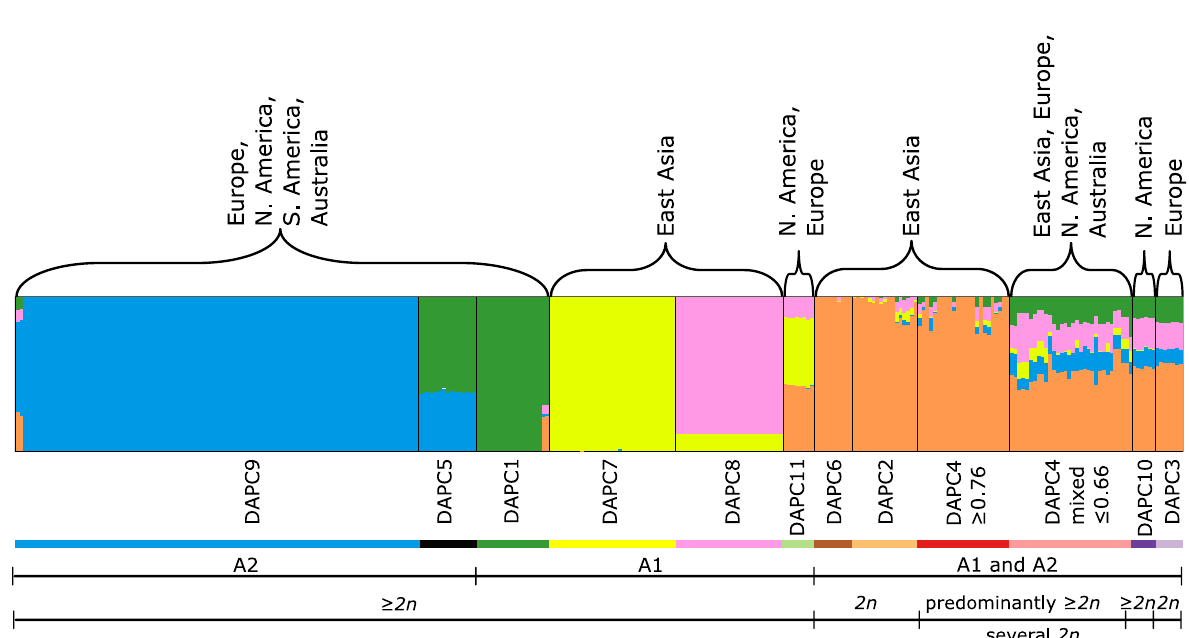
Fig. 1 Bayesian clustering of P. cambivora -related isolates using STRU CTU RE at K 5. Each isolate is represented by a vertical line partitioned × = into coloured sections that represent the isolate’s estimated membership fractions in each cluster. Black lines separate isolates from different DAPC groups (see main text for details). The horizontal colour bar below the DAPC group name represents the colour used for that group in maps and supplementary figures. The mating type (A1 or A2) and ploidy level (diploid 2n or higher) of each group is given below the plot and the = geographic distribution of the group is given above the